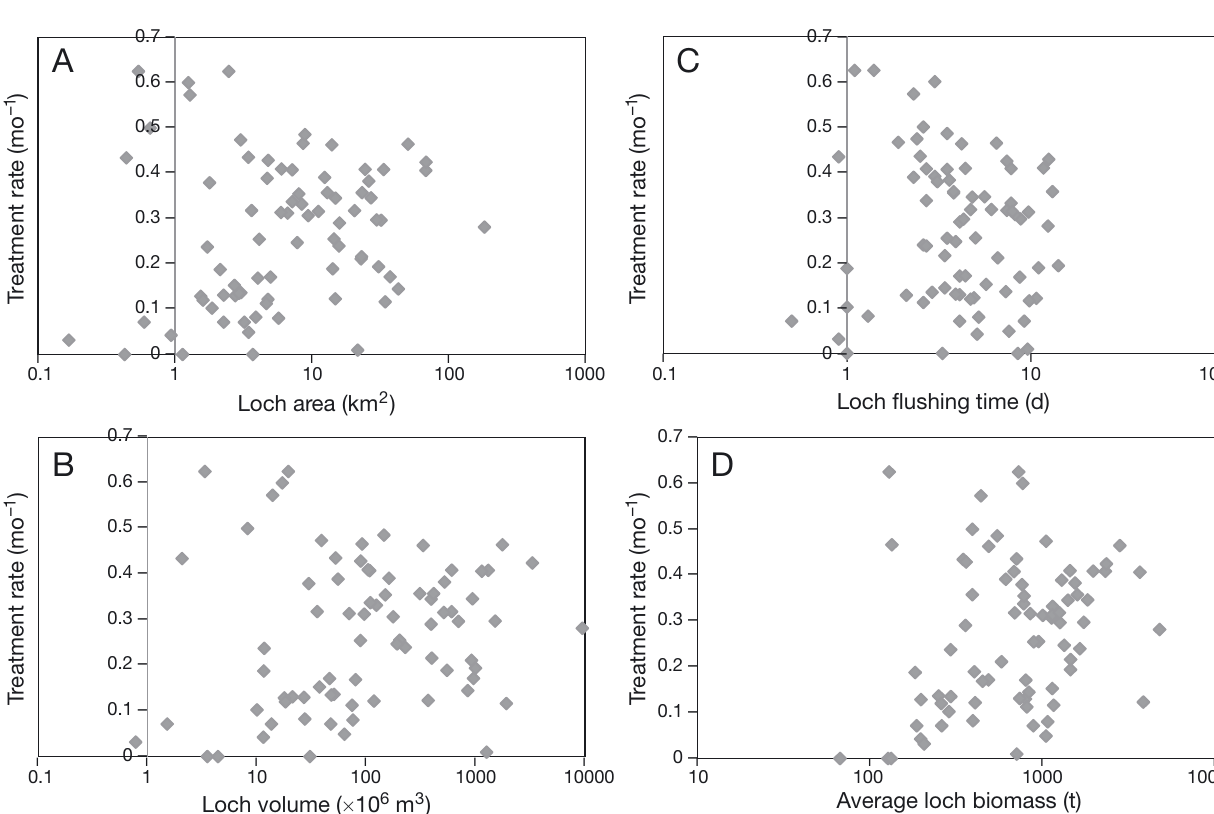
Fig. 4. Univariate associations of loch-level parameters (A: area; B: volume; C: flushing time; D: loch biomass) with loch- level treatment rates